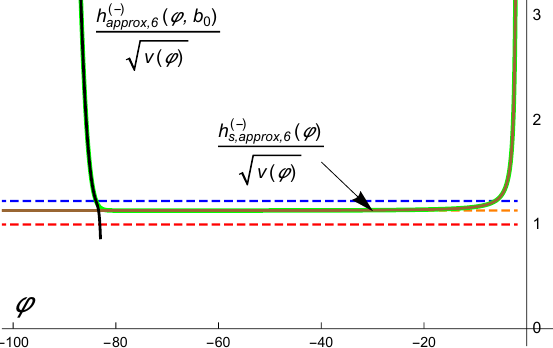
Figure 5. The green line shows the numerical solution of Equation (89) with initial conditions ( − ) ( ϕ ) / (cid:112) v ( ϕ ) with b = 2 × 10 24 . The black line shows the six -order ϕ 0 = − 100, h 0 = h 0 , b 0 0 0 approx ,6 ( − ) ) / (cid:112) v ( ϕ ) . The brown line shows the sixth -order approximation ( ϕ , b KD approximation h 0 approx ,6 ( − ) ( ϕ ) / (cid:112) v ( ϕ ) to the separatrix. The orange dotted line corresponds to the asymptotic be- h s , approx ,6 haviour of the separatrix solution h s ( ϕ ) ∼ ( 1 − λ 2 ) − 1/2 as ϕ → − ∞ . The values of the parameters √ √ 3 2 are λ = , µ = , c 1 = 2 × 10 − 10 , c 2 = 2.5 × 10 − 10 . We notice that the green line (numerical 3 4 approximation) is overlapped by the black line (KD approximation) in the KD region and by the brown line (separatrix approximation) in the SR region. The region between the blue and red dotted lines is the inflation